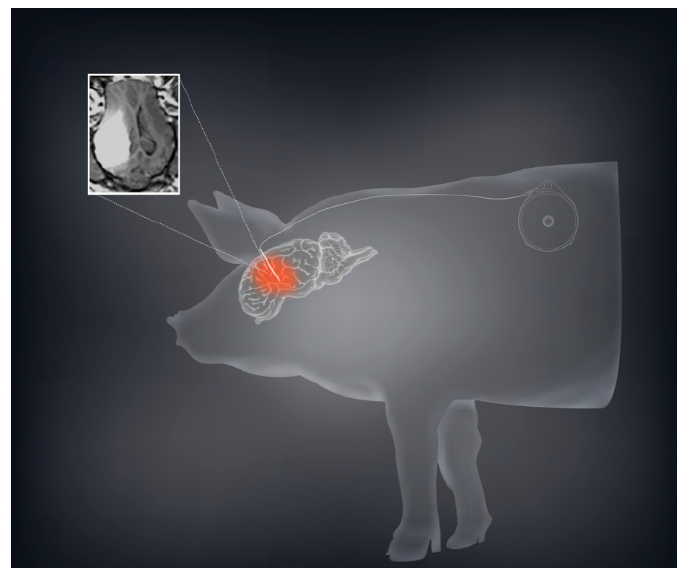
Figure 2. CED using a subcutaneous implantable pump is safe and feasible in a large animal model. A schematic demonstration with the sample MRI of convection volume with co-infusion of topotecan and gadolinium is shown demonstrating a sizeable volume of distribution.